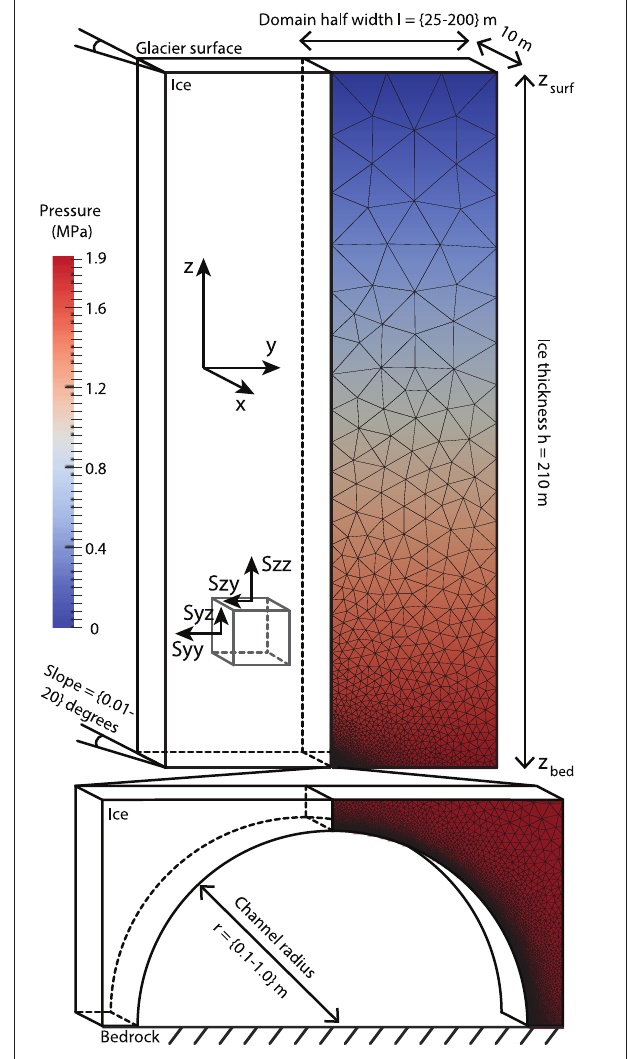
FIGURE 5 | Geometry and discretisation of the model domain. Only one half of the subglacial channel and surrounding glacier ice is modelled due to symmetry. The colour represents pressure in the ice column for a constant water pressure in the subglacial channel that is equal to the balance hydrostatic